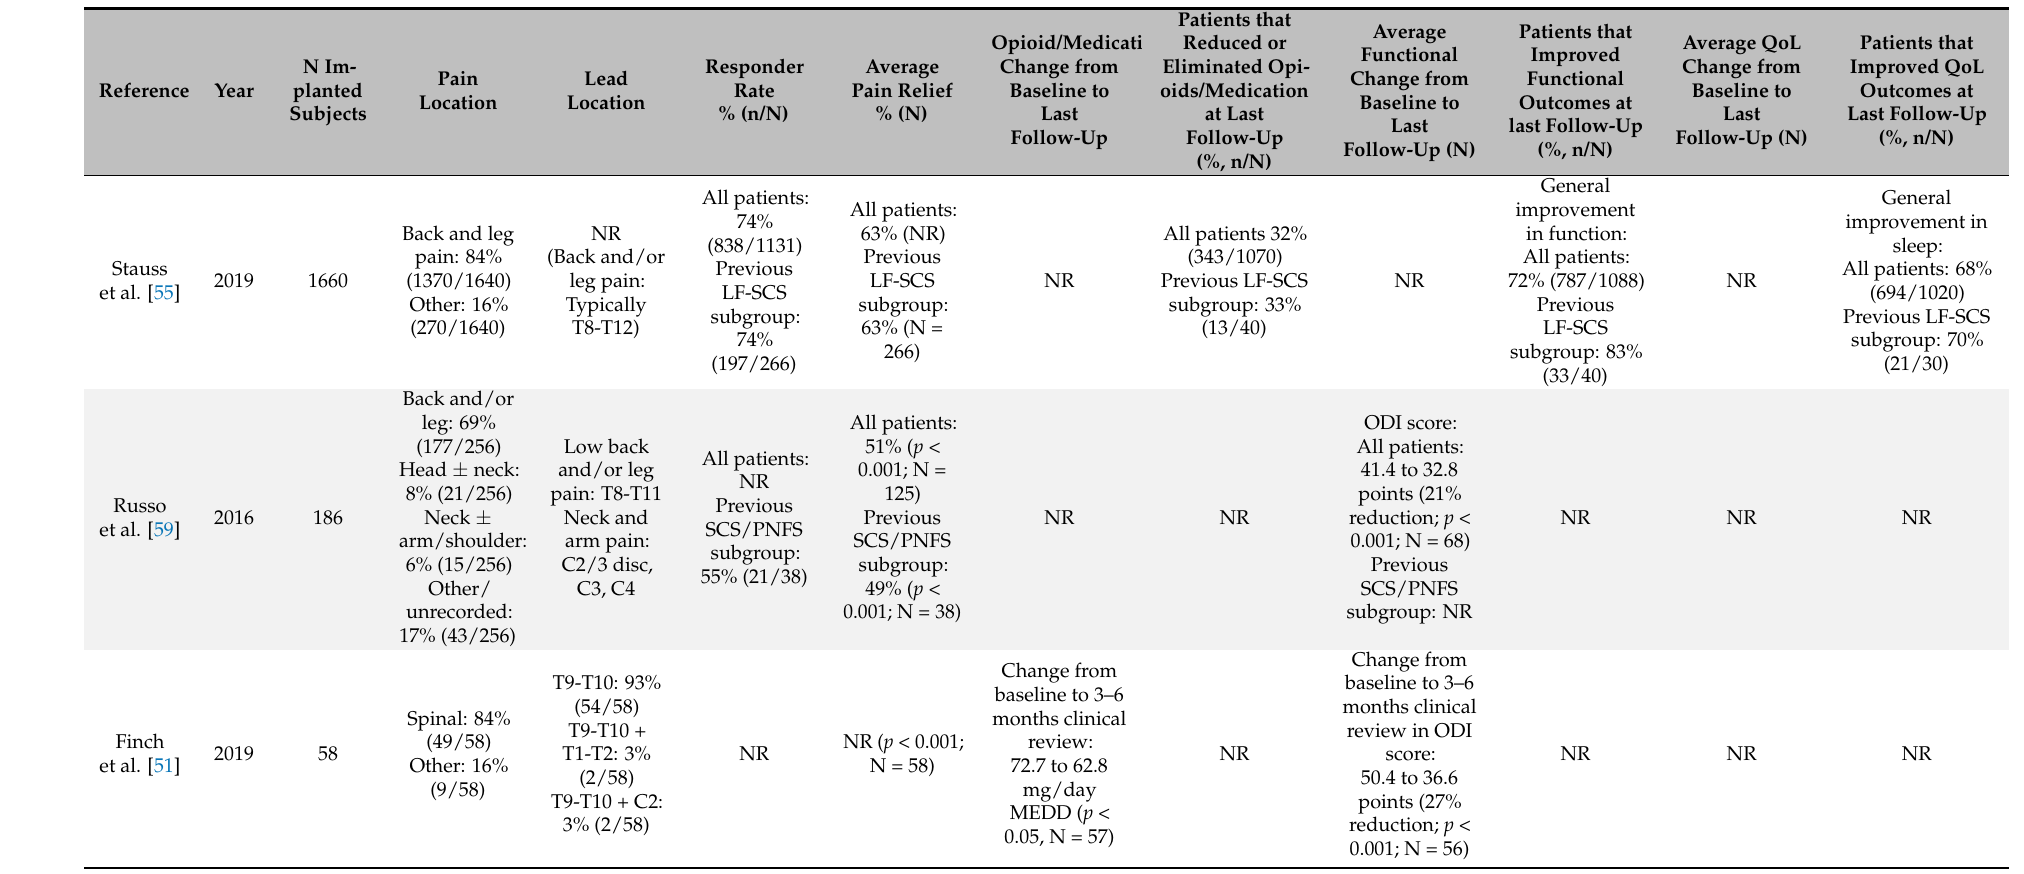
Table 2. Study effectiveness